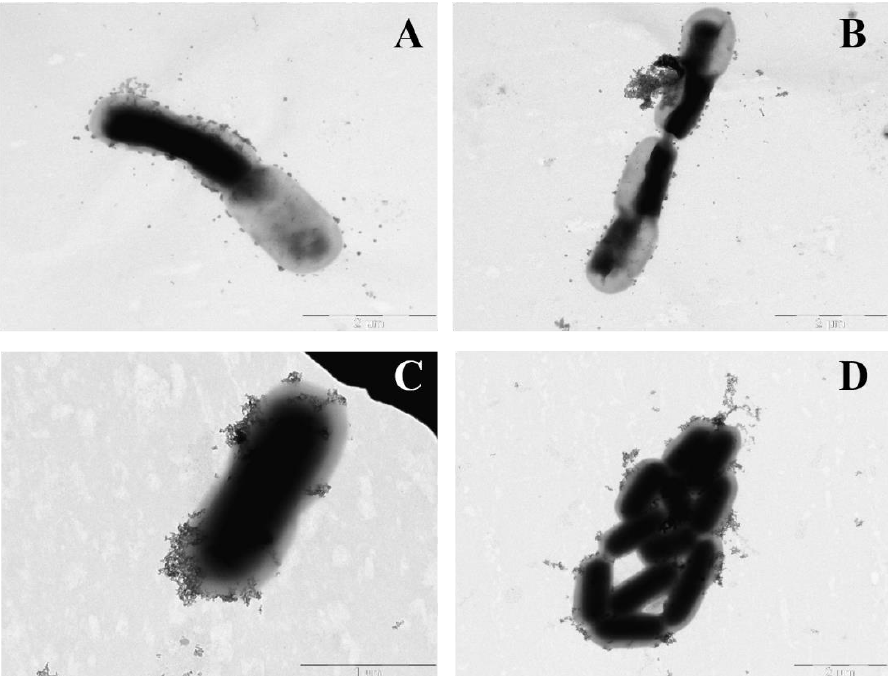
Figure 9. The TEM microphotographs of HPCDpol-Cu 2+ particle adsorption on B. subtilis ATCC 6633 ( A , B ) and L. fermentum 90T-C4 ( C , D ), H 2 O, 20 min of incubation, 37 °C, C(Cu 2+ ) ~0.001 M, 80 mV. ( A , B ) and L. fermentum 90T-C4 ( C , D ), H 2 O, 20 min of incubation, 37 ◦ C, C(Cu 2+ ) ~ 0.001 M, 80 mV. Scale bars: 1 μ m ( C ) and 2 μ m ( A , B , D ). Scale bars: 1 µ m ( C ) and 2 µ m ( A , B , D